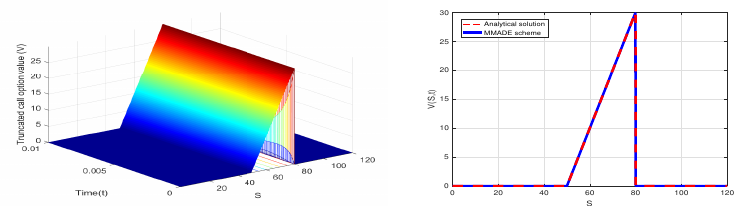
Figure 8. Numerical solution provided by the MMADE scheme. Parameters: r = 0.07, σ = 0.001, a = − 8800, T = 0.01, U = 80, K = 50, L = 20, S max = 120, ∆ S = 0.01, ∆ t = 10 − 4